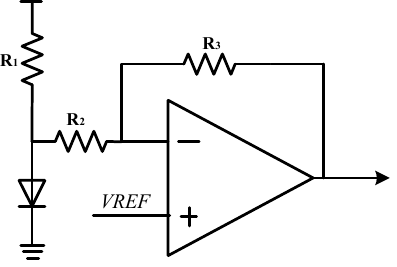
Figure 15. Negative temperature coefficient temperature sensor.